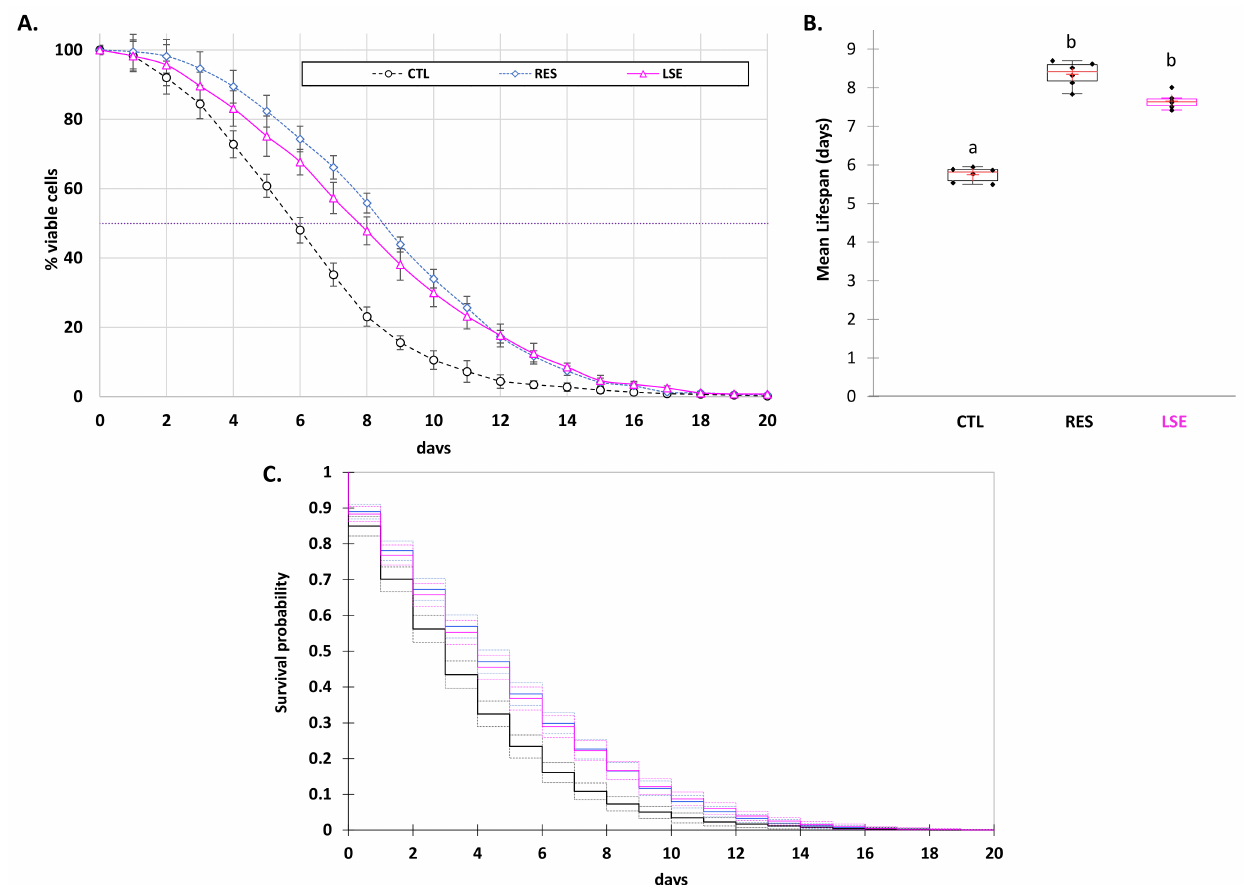
Figure 2. ( A ) Viability plot of yeast (strain DBY746) determined using the microcolony method on yeast extract peptone dextrose (YPD) plates. ( B ) Mean of chronological lifespan yeast (strain DBY746) calculated using the viability plot. Significant differences ( p < 0.05) are shown by different letters. ( C ) Kaplan–Meier estimator showing the survival function from the viability plot. The values represent the means and standard deviations of six independent experiments. LSE: sacred lotus stamen extract (0.5 mg/mL); RES: E-resveratrol (10 µ M) used as positive antiaging